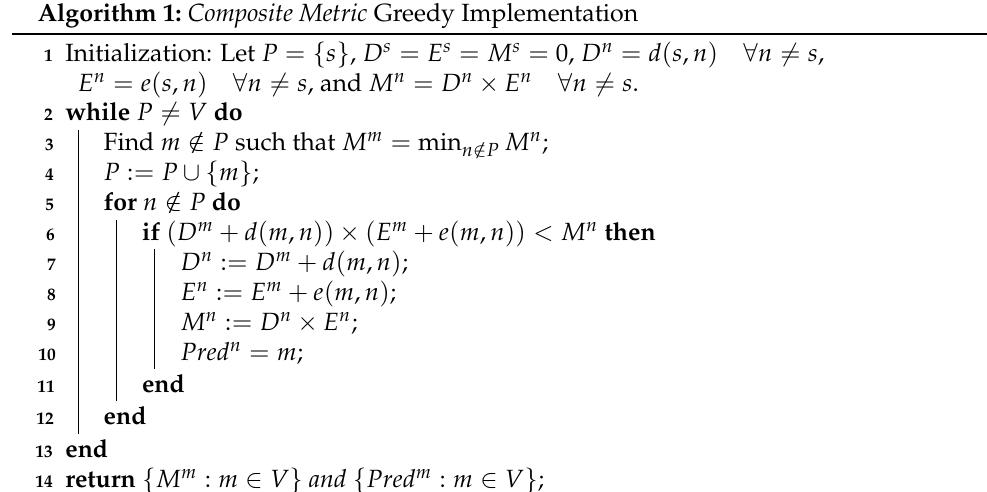
Algorithm 1: Composite Metric Greedy